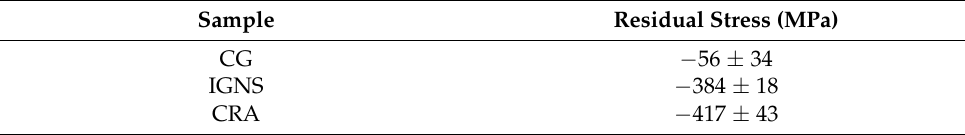
Table 3. Residual stress of the surface layer in the CG, IGNS, and CRA